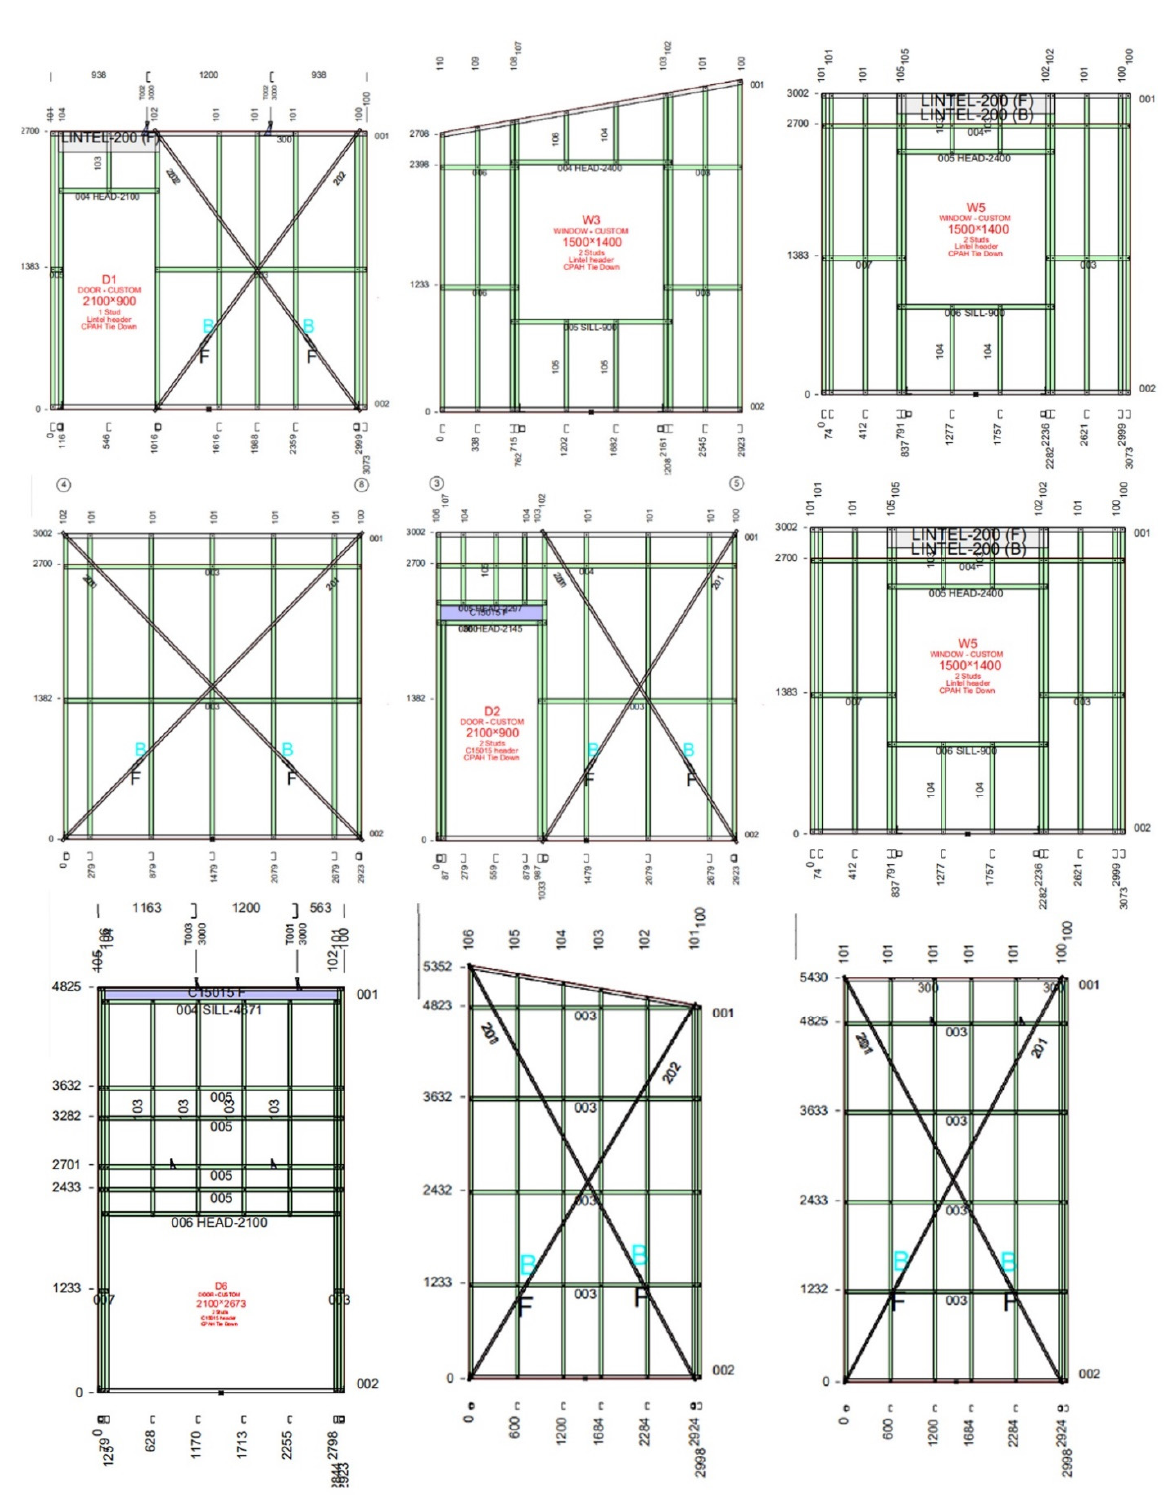
Figure 2. Assembly detail of LSF.